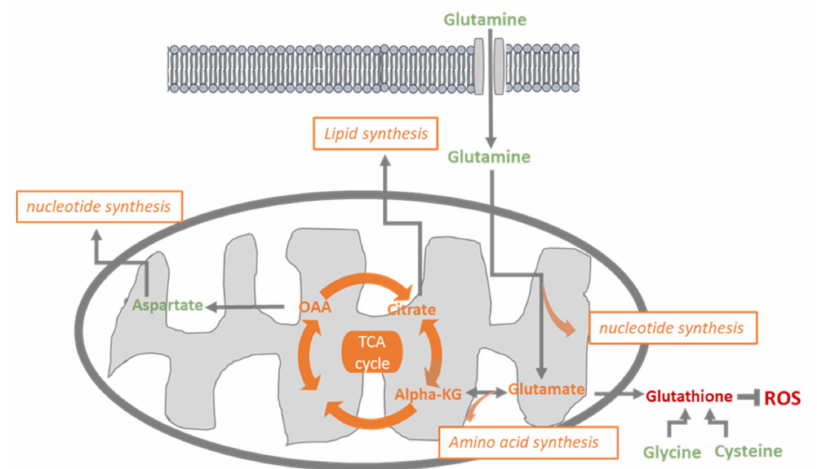
Figure 6. Glutamine metabolism: glutamine enters into the cell and can contribute to nucleotide synthesis or be converted into glutamate; glutamate participates in glutathione synthesis and can be converted to α -ketoglutarate (alpha-KG), which fuels the TCA cycle, which produces oxaloacetate (OAA) and citrate. OAA can be converted to aspartate and participate in nucleotide synthesis, citrate supports lipid synthesis